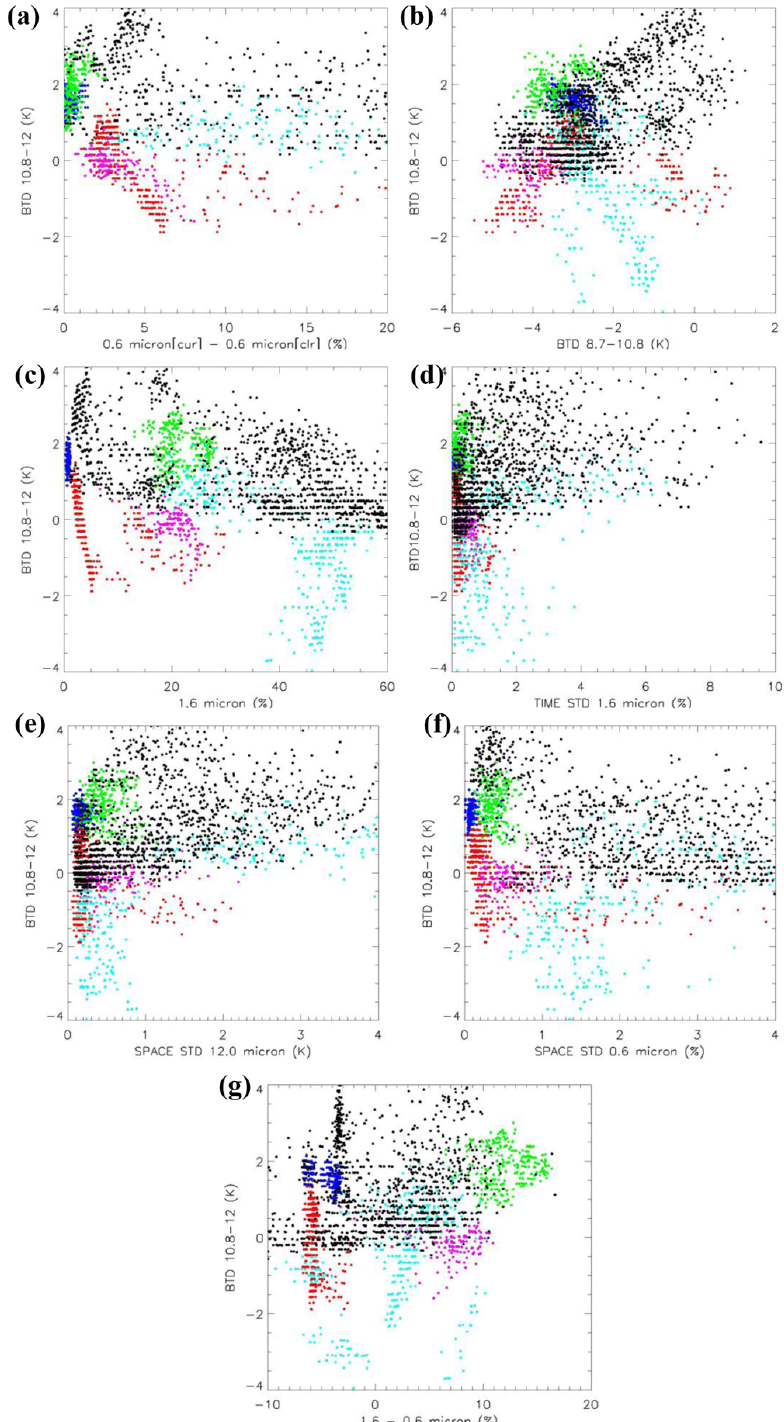
Fig. 3. Bispectral plots for the SEVIRI channels of most interest to this study from the samples in Fig. 2; ocean is blue, land is green, ash over water is red, ash over land is pink, ash above cloud is light blue, and cloud is black. (a) 0.6µm cur –0.6µm clr versus BTD 10.8–12.0, (b) BTD 8.7–10.8 versus BTD 10.8–12.0, (c) 1.6µm versus BTD 10.8–12.0, (d) σT 1.6µm versus BTD 10.8–12.0, (e) σs 12.0µm versus BTD 10.8–12.0, (e) σs 0.6µm versus BTD 10.8–12.0, and (f) 1.6µm–0.6µm versus BTD